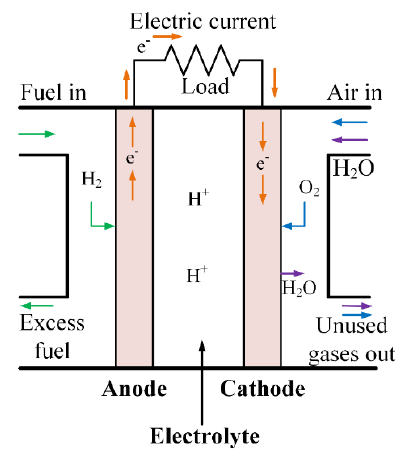
Figure 64. Schematic diagram of proton exchange membrane fuel cell (PEMFC); a solid polymer Teflon-like membrane is used as the electrolyte to separate hydrogen and the oxygen [196].